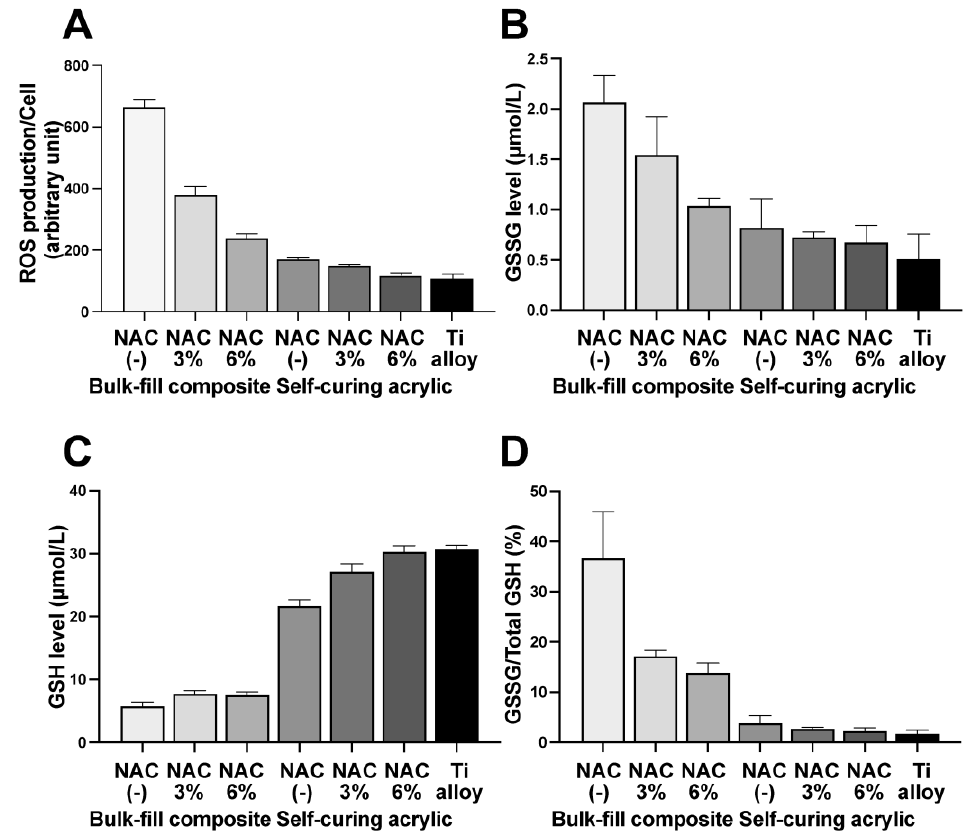
Figure 8. NAC-mediated improvements in antioxidant defenses. ( A ) ROS levels in fibroblasts collected from the proximity experiment. ( B ) GSSG (glutathione disulfide, an oxidized form of glutathione) levels in fibroblasts collected from proximity experiment. ( C ) GSH (a reduced form of glutathione) levels in fibroblasts collected from proximity experiments. ( D ) GSSH/GSH in fibroblasts collected from the proximity experiment.